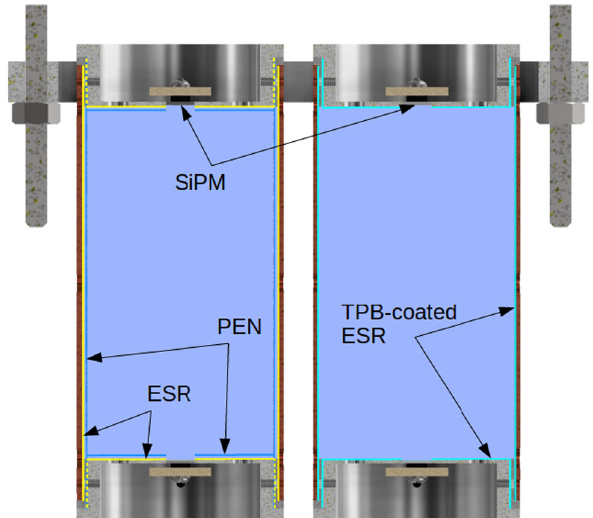
Fig. 1 Schematic of 2PAC (see text for more details). Sectional view shows thelocationofphoto-detectors andthearrangementoffoils:ESR (yellow) and PEN (blue) in the left chamber, TPB-coated ESR (cyan) in the right chamber